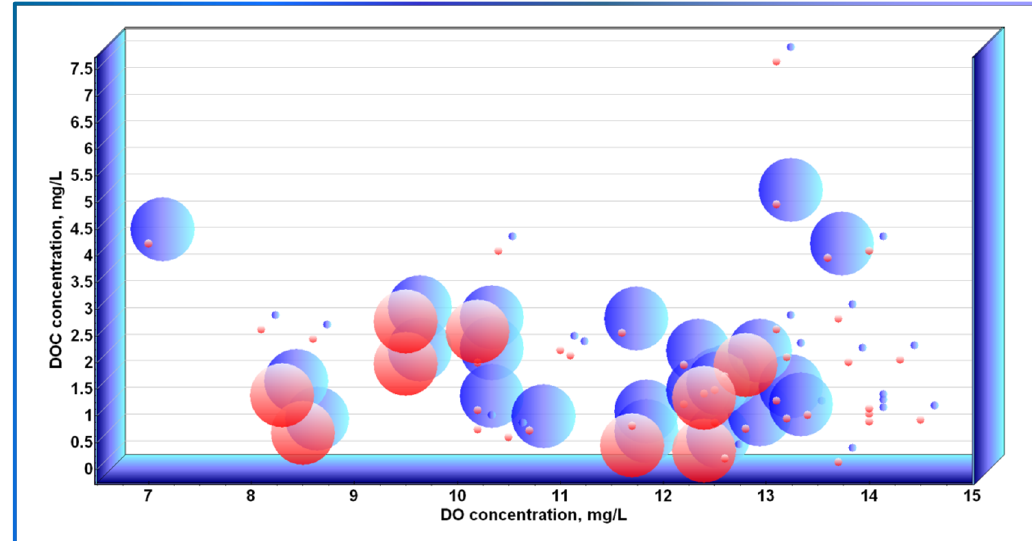
Figure 12. Bubble plot of the Pb and Fe concentrations combined interaction on TC ( blue ) and E. coli ( red ).